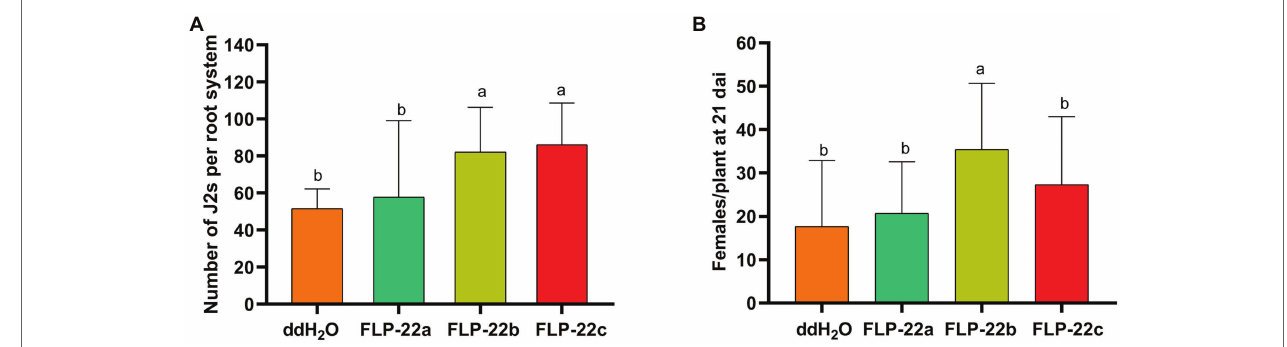
FIGURE 7 | Effect of Hg-FLP-22 peptides on infection and development of H. glycines in soil. (A) Host invasion ability of Hg-FLP-22 peptides or ddH 2 O-treated nematodes in soybean roots in pots containing sterilized sand and soil. Each plant was inoculated with 200 J2s. The number of nematodes in soybean roots was counted at 24 hai through acid fuchsin staining. Bars are the mean ± SD from one representative experiment ( n = 8). These experiments were repeated three times with similar results. (B) Females in soybean roots were counted 21 dai. Values are the means ± SD from eight plants and are representative of three independent experiments. The same letters indicate no significant differences between the peptide treatments and ddH 2 O control as determined by Dunnett’s test at p >